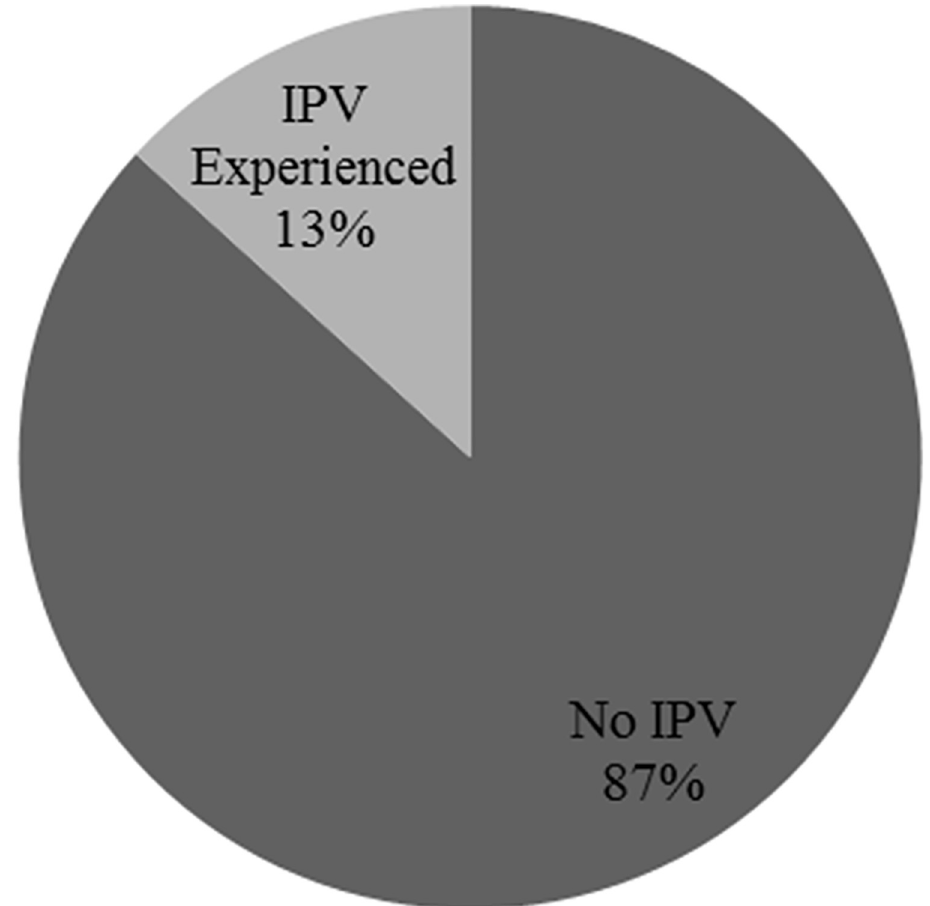
Fig 1. Experience of IPV of South African women of reproductive